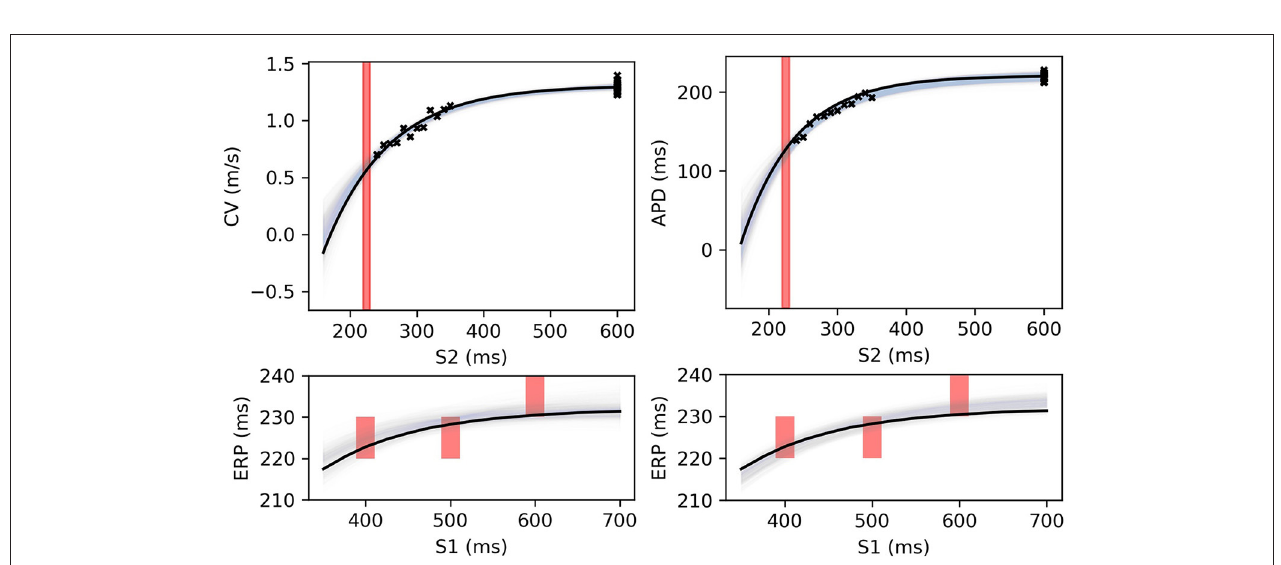
FIGURE 9 | RCE predictions, shown as lightly shaded regions representing 95% confidence intervals, for 100 parameter samples from the posterior distribution given the same measurements shown in Figure 8 [black crosses are noisy S2 restitution data, red bars are observed ERP intervals, (left) MCMC with CV(S2) and ERP(S1) data, (right) MCMC with APD(S2) and ERP(S1)